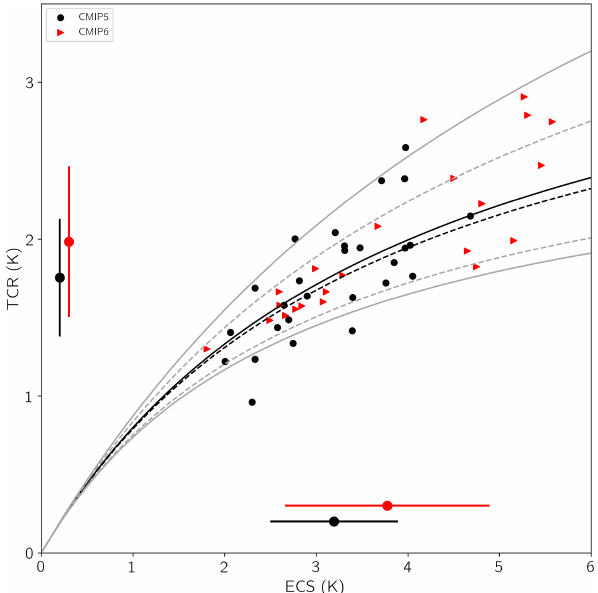
Figure 11. TCR versus ECS for the CMIP5 ensemble (black circles) and CMIP6 ensemble (right-facing red triangles). Ex- pected values based on forcing of 3.7Wm − 2 and a value of (cid:15)γ = 0 . 93Wm − 2 K − 1 are shown by the black curve, and uncertainty of the (cid:15)γ value is shown as gray bounding lines. Dashed black and gray curves represent the same expected values but are based on a value of (cid:15)γ = 0 . 98Wm − 2 K − 1 computed from the CMIP6 en- semble. ECS and TCR mean values and SDs for the CMIP5 and CMIP6 ensembles are displayed in black and red, respectively.